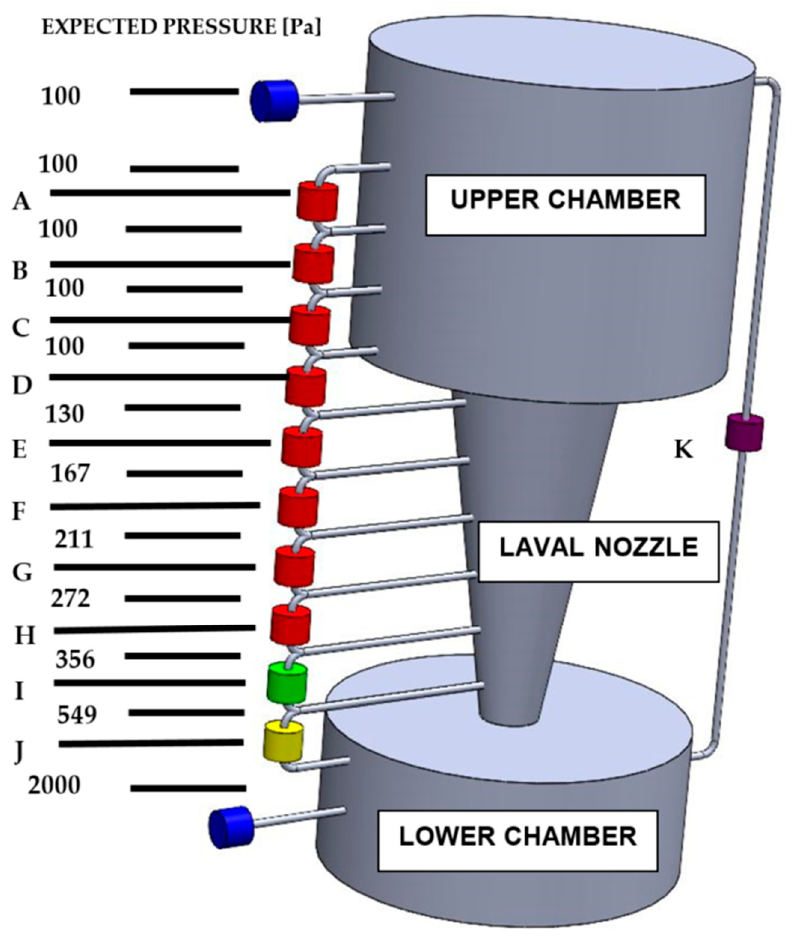
Figure 13. Probe placement on the experimental chamber. Table 3. The expected pressure difference in the pressure probes.